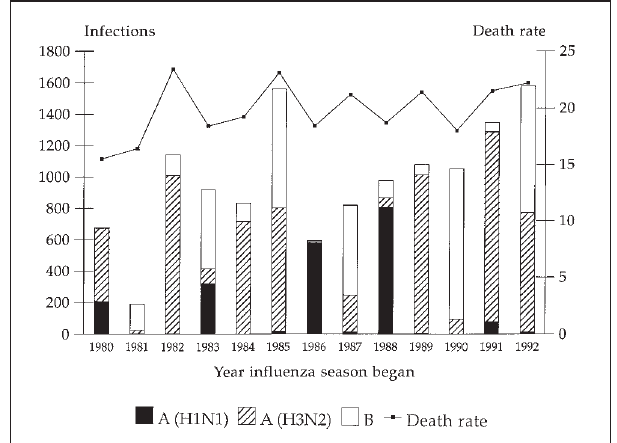
Figure 2) Relationship of pneumonia and influenza hospitalizations and deaths to laboratory-confirmed influenza infections in Canada for influenza seasons from 1980 to 1992. (cid:1) Hospitalization rates; (cid:2) Death